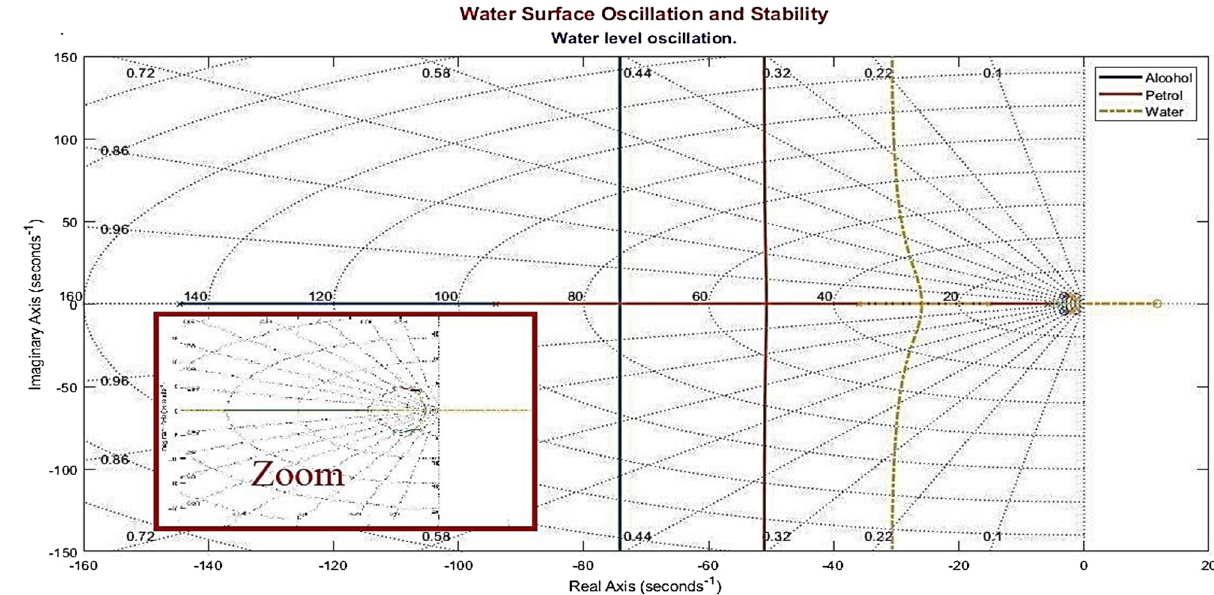
Figure 7: Stability of the system with di ff erent fl uid type e ff